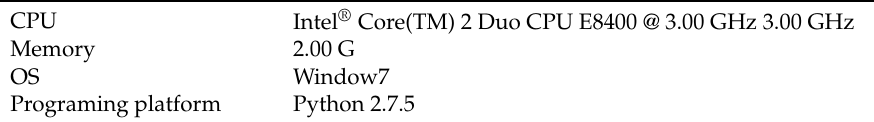
Table 1. Software and hardware